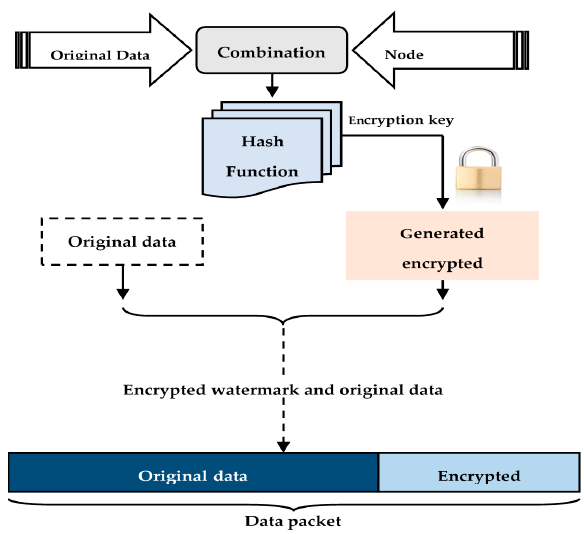
Figure 8. CLDWA embedding (the heterogeneous nodes level).